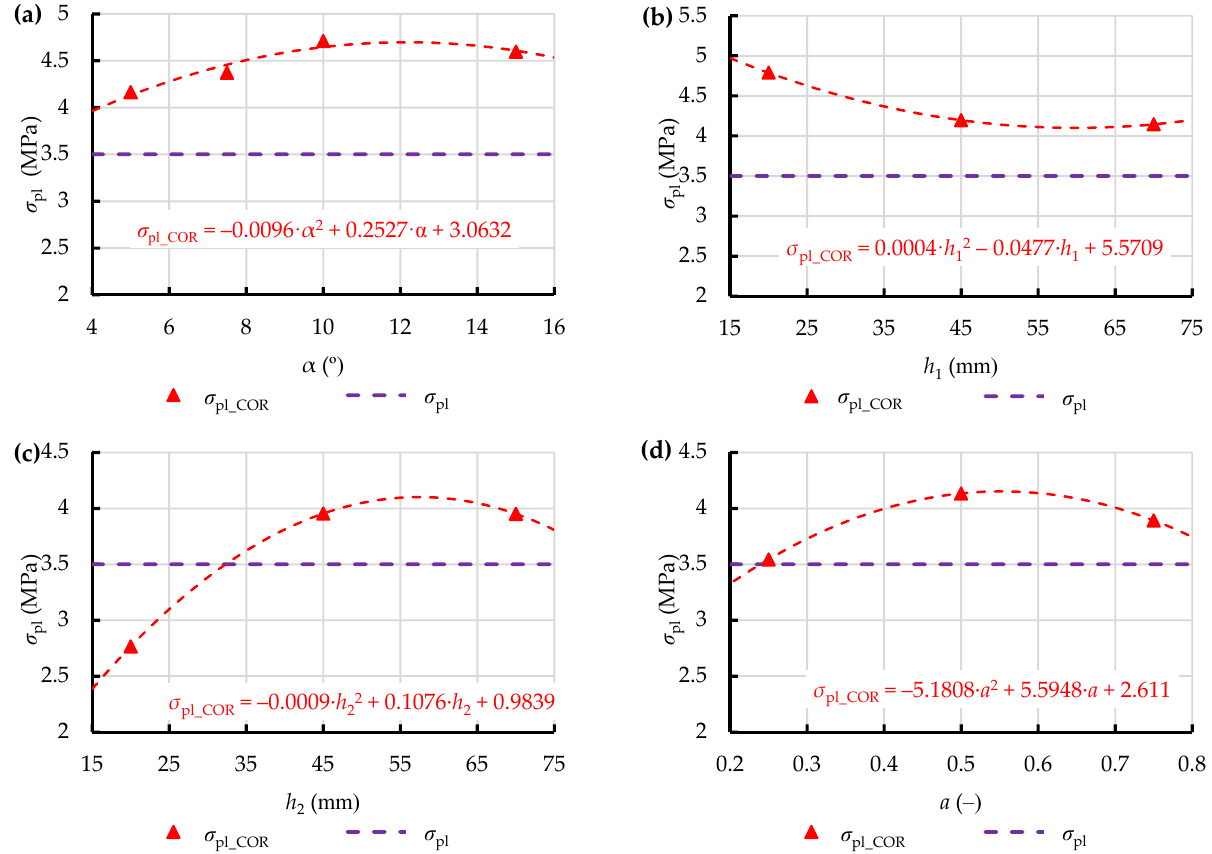
Figure 15. Values of the corrected yield stress of compressed dry ice snow σ pl_COR depending on the geometric parameters of single-hole dies, and their comparison with the constant σ pl for dies of groups CS ( a ), WK ( b ), WP ( c ), and WKWP ( d ). The obtained corrected yield stress values σ pl_COR were used in the repeated numerical calculations performed with the use of the SPH method. Other settings remained unchanged. The results of the comparison between the corrected extrusion resistance force F L_FEM_COR and the observed values of this force F L_EMP are shown in Figure 16, together with the percent difference between these two Δ F L_COR . As it can be seen, this treatment improved the accuracy of representation of the process by numerical analysis, with regards to the obtaining of the maximum extrusion resistance force. After correction of the initial yield stress the percent difference did not exceed 10%, and the curves of F L_FEM_COR and F L_EMP became more similar in terms of monotonicity (as compared to the curves obtained for the constant value of σ pl ).